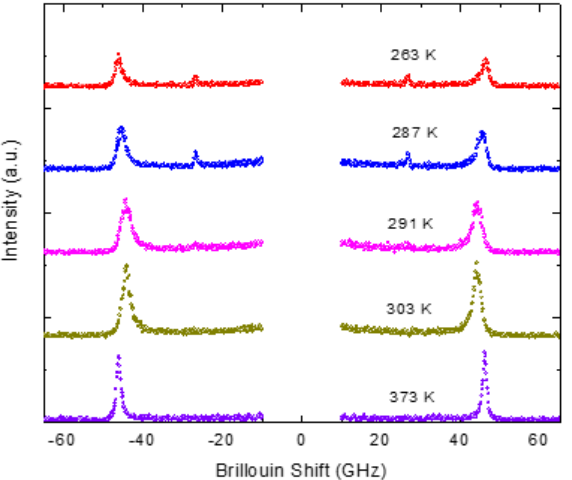
Figure 9. Brillouin spectra of PST measured in the FSR range of 75 GHz.